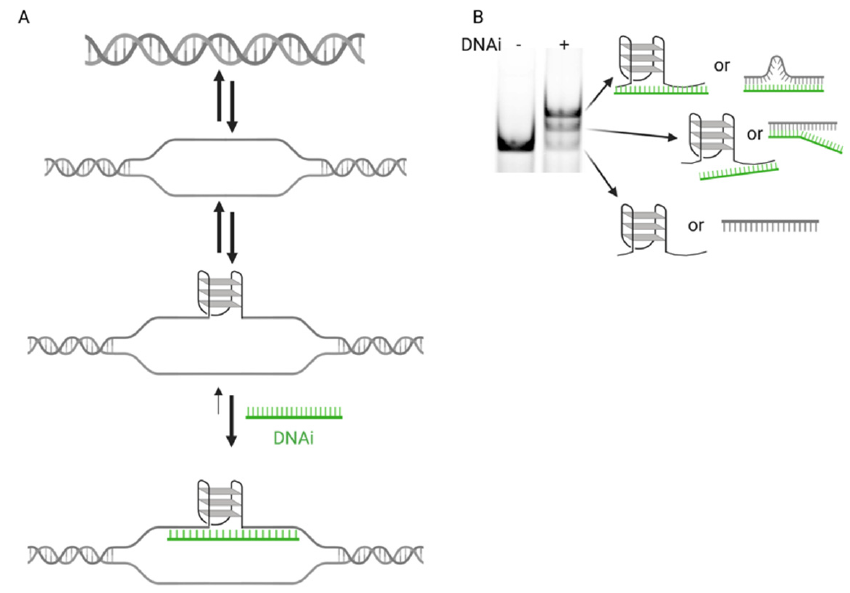
Figure 1. Proposed DNAi mechanism of action for MYC G4 recognition. ( A ) dsDNA opens up on a transient basis due to superhelical stress and is capable of forming a higher-order G4 structure. Adding DNAi that complements the regions flanking the G4-forming promoter section can shift the equilibrium to maintain more G4 formation, enhancing the silencing function within the MYC promoter. ( B ) EMSA separation of the higher-order DNA species can differentiate between unbound linear or G4 DNA, DNA wherein the DNAi complements the G4-forming region on one flank, and DNA where the DNAi captures both flanking regions.